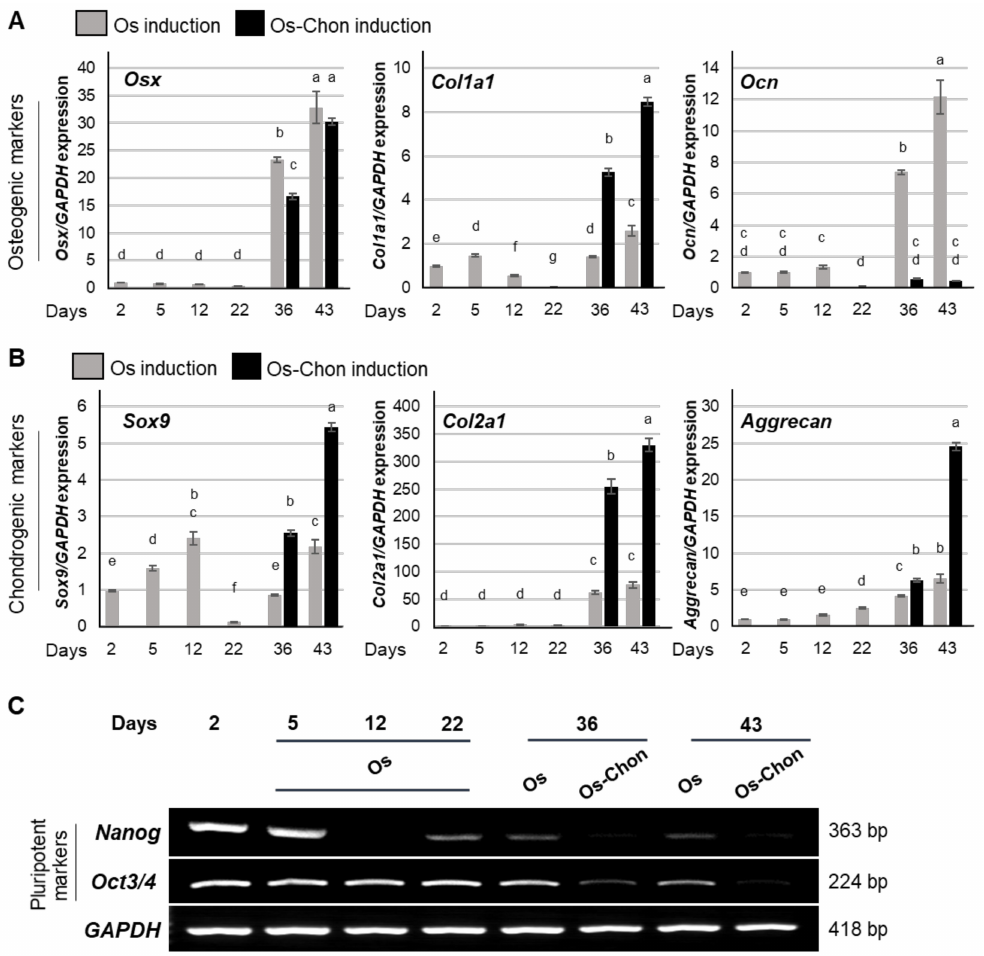
Figure 1. E ff ects of osteogenic (Os) induction and osteo-chondrogenic (Os-Chon) induction on osteochondrogenic di ff erentiation of three-dimensional-induced pluripotent stem cells (3D-iPSC) constructs. Expression of ( A ) osteogenic marker genes [ osterix ( Osx ), collagen 1a1 ( Col1a1 ) and osteocalcin ( Ocn )] and ( B ) chondrogenic marker genes [ Sox9 , collagen 2a1 ( Col2a1 ) and aggrecan ] were evaluated using real-time reverse transcription polymerase chain reaction (RT-PCR) on day 2 (the day when the induction commenced), on days 5, 12, and 22 (Os induction; same induction protocol as Os-Chon induction during this period) and on days 36 and 43 (Os or Os-Chon induction). The data represent the mean ± SD ( n = 3). Di ff erent letters indicate significant di ff erences between groups ( p < 0.05, one-way analysis of variance (ANOVA) with Tukey’s multiple comparison test). ( C ) Expression of pluripotency marker genes, Nanog and Oct3 / 4 , was evaluated by semi-quantitative RT-PCR analysis. GAPDH expression was used as an internal